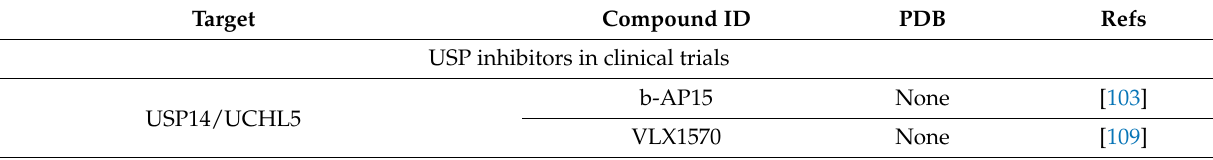
Table 2. List of reported USP